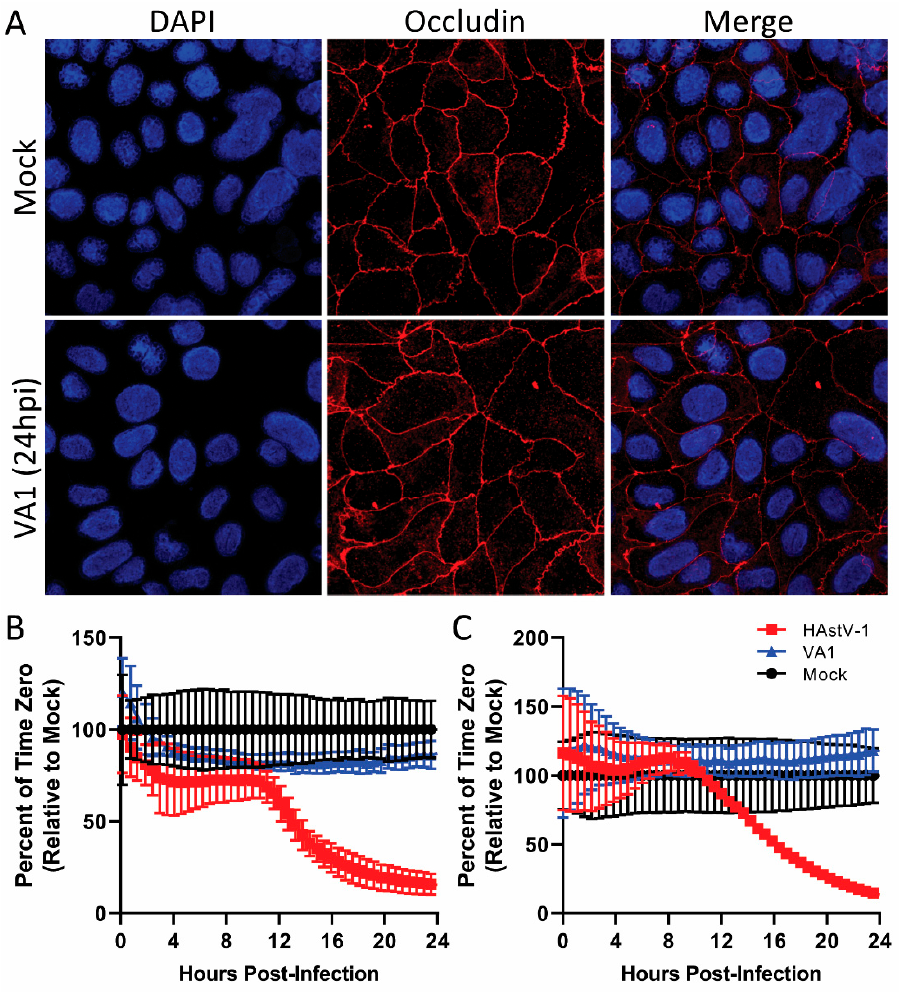
Figure 5. VA1 infection does not induce barrier permeability. ( A ) Representative images, taken at 60 × magnification on Zeiss LSM 780 NLO, of Caco-2 monolayers infected with VA1 (MOI of 10) at 24 hpi show no disruption of occludin expression compared to mock-infected cells. Caco-2 monolayers grown on semi-permeable supports were infected with HAstV-1, VA1 at MOIs of 1 ( B ) and 10 ( C ), or mock-infected and transepithelial electrical resistance (TER) was measured from 0–24 hpi.